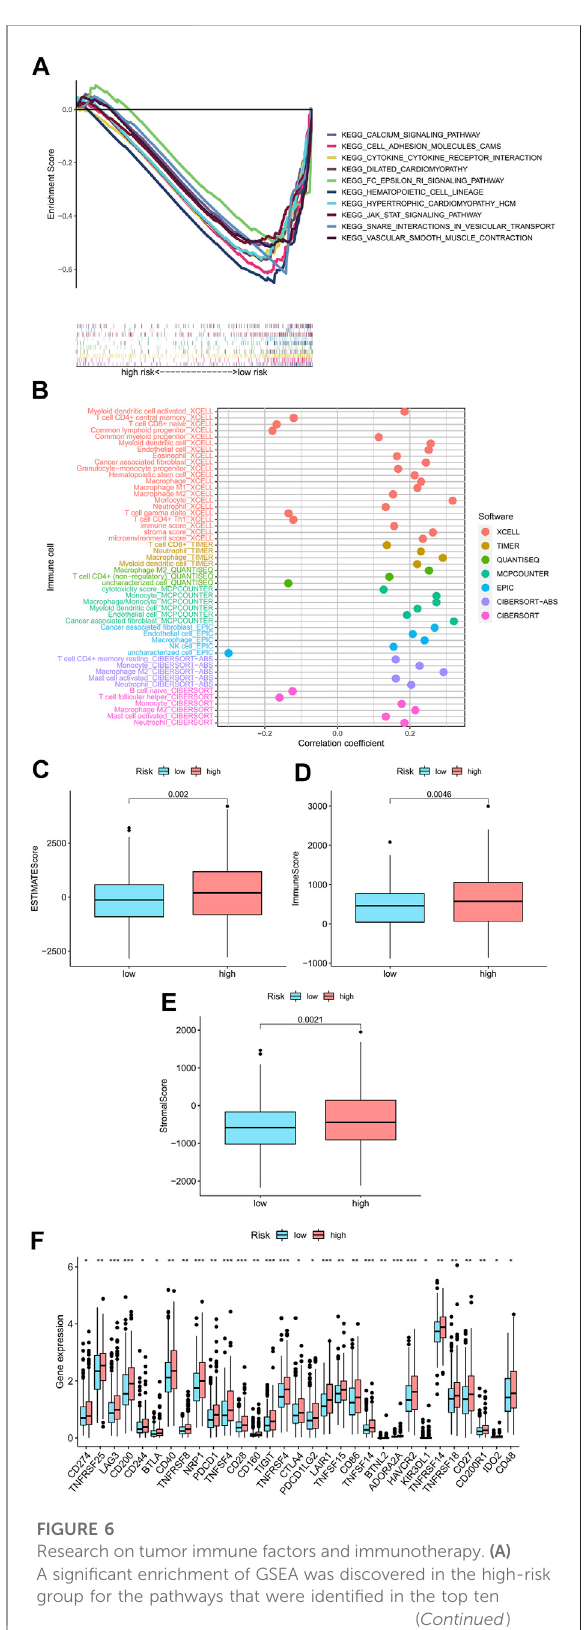
FIGURE6 | pathways. (B) Immunecellbubblesinriskgroups. (C – E) Comparing immunity scores in low- and high-risk groups. (F) Different expressions of 15 checkpoints in risk